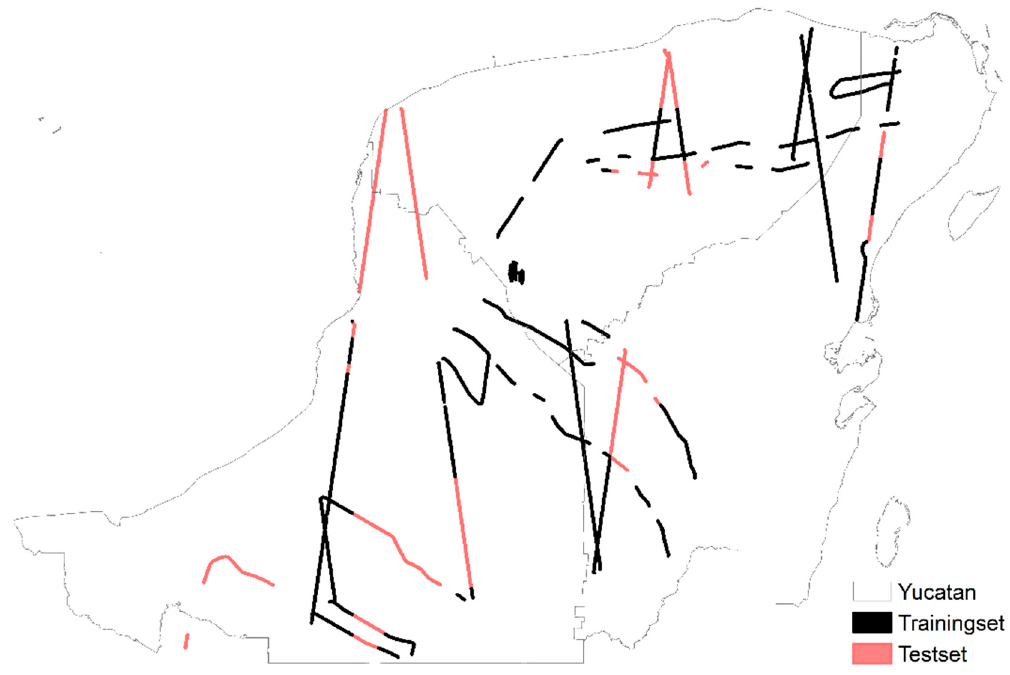
Figure 3. Location of training and validation data using the “spatial sampling” approach of the LiDAR metric p100. Black stripes represent model training data; red stripes represent validation data.